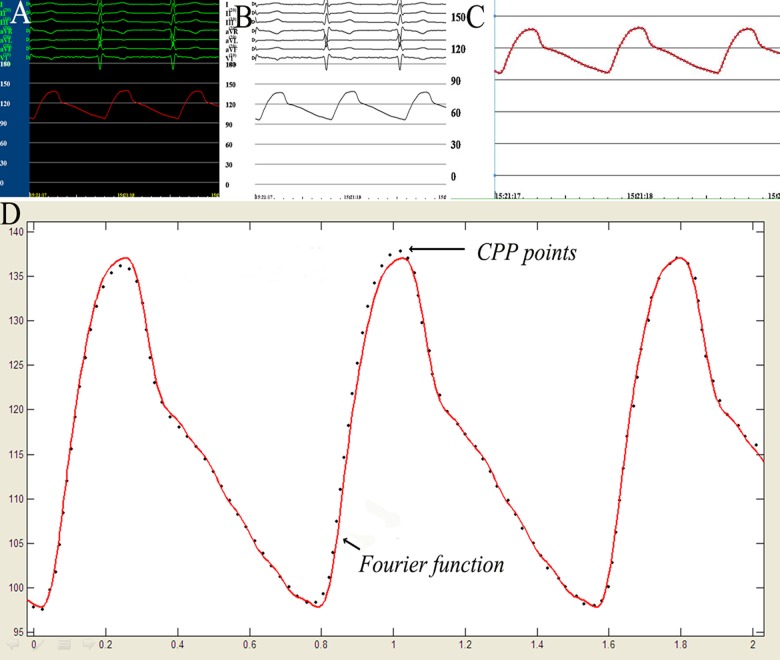
Application of MATLAB 7.0,Photoshop 7.0.1 and GetData Graph Digitizer 2.25 to construct a Fourier function fitting a CPP curve.